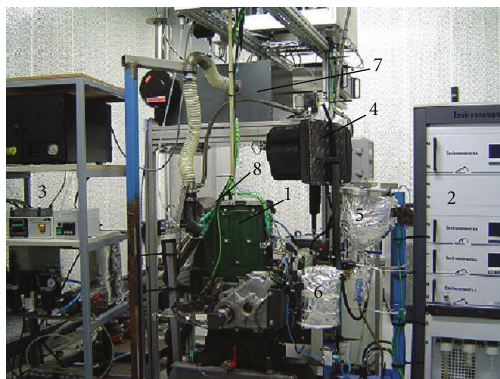
Figure 1: Photographic view of the experimental setup. (1) Diesel engine, (2) gas analyzer, (3) particulate analyzer, (4) diesel tank, (5) biodiesel tank, (6) orifice meter, (7) air tank, (8) wires of di ff erent